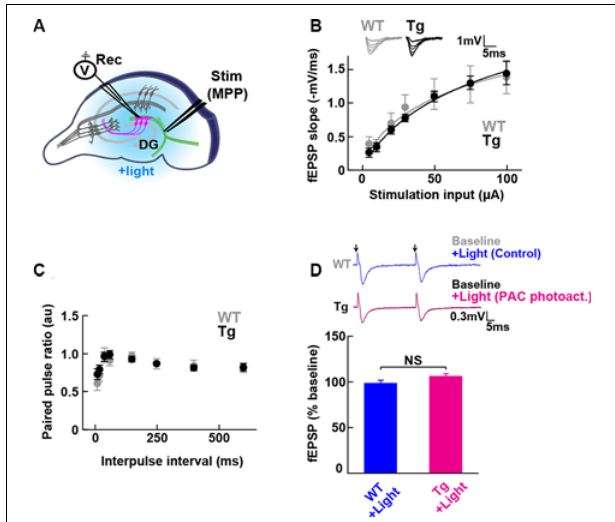
FIGURE 2 | Baseline transmission at medial perforant path to granule dentate gyrus (MPP-DG) synapses of Tg and WT mice. (A) Schematic of the DG recording (Rec) electrode to detect fEPSPs upon stimulation (stim) of the MPP of hippocampal brain slices. Light was delivered for photoactivation (blue light, 480 ± 15 nm) of PAC expressed within granule neurons (magenta). (B) Input/output relationship within MPP-DG synapses in the absence (WT) and presence of PAC (Tg; WT n = 7 slices/3 mice, Tg n = 16 slices/9 mice). Inset shows sample I/O responses superimposed. (C) Comparison of the paired-pulse ratio (PPR) calculated from the ratio of the second fEPSP slope to the first, at different interpulse intervals (WT n = 12 slices/4 mice, Tg n = 15 slices/7 mice). (D) Quantification of synaptic response with/without PAC photoactivation for 60 s during the baseline recording (Tg n = 11 slices/7 mice, WT n = 13 slices/3 mice). NS, p > 0.05 (unpaired t -test). Data are presented as mean ± SEM. Upper: sample paired-pulse traces show the fEPSP responses before (Baseline) and 1 min after (+Light) light stimulation. Black arrows indicate the time of the single pulses of stimulation.